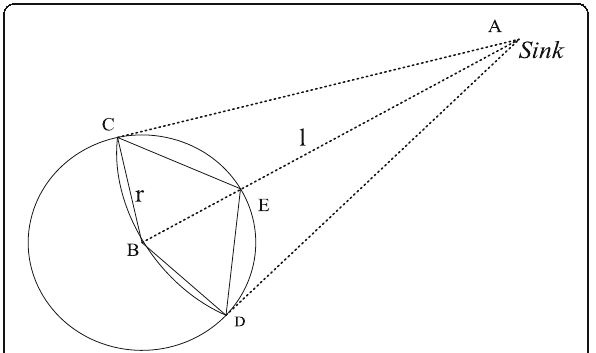
Fig. 3 Optional range of forwarder